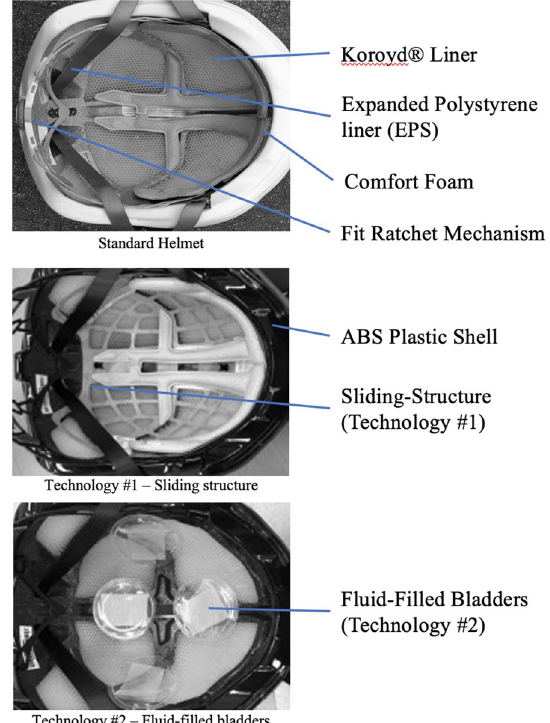
Figure 1. Cycling helmets tested, standard helmet (top), Technology #1 (MIPS), (centre), and Technology #2,